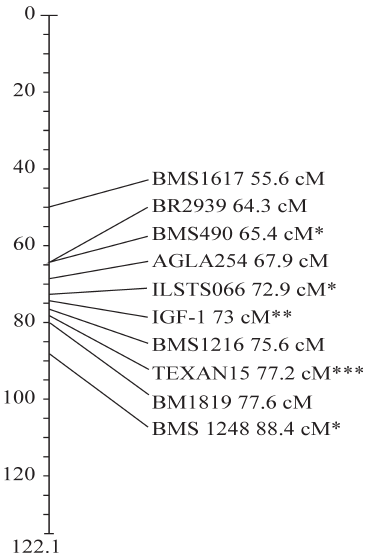
Figure 1 - Approximate location of the molecular markers tested in the genotypic analysis of the sires. The top of the vertical line corresponds to the centromeric extremity of chromosome 5. *Selected markers for half- sib analysis. **Candidate IGF-1 gene. ***The position of marker TEXAN15 was inferred by comparison with common markers of the MARC and Texas A&M University